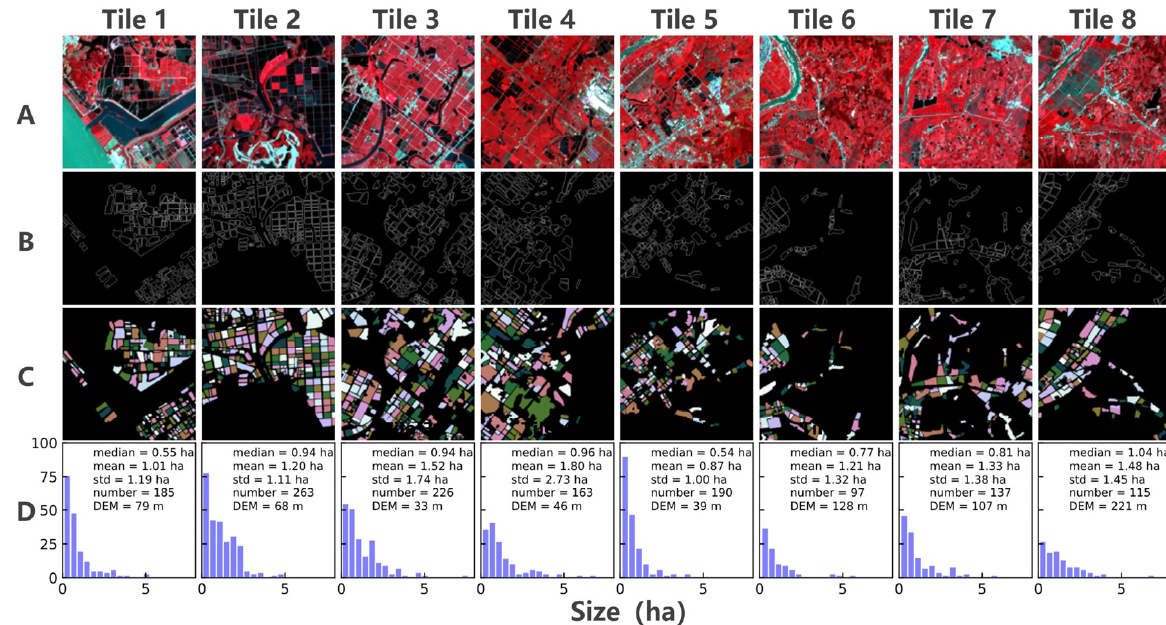
Figure 2. The eight typical test tiles and associated reference cropland parcels in this study. ( A ) The pseudo-color composition image of each tile, ( B ) boundaries of the reference cropland parcels, ( C ) individual cropland parcels denoted by random colors, and ( D ) the cropland parcel size distribu- tions and the topological characteristics over eight typical test tiles.